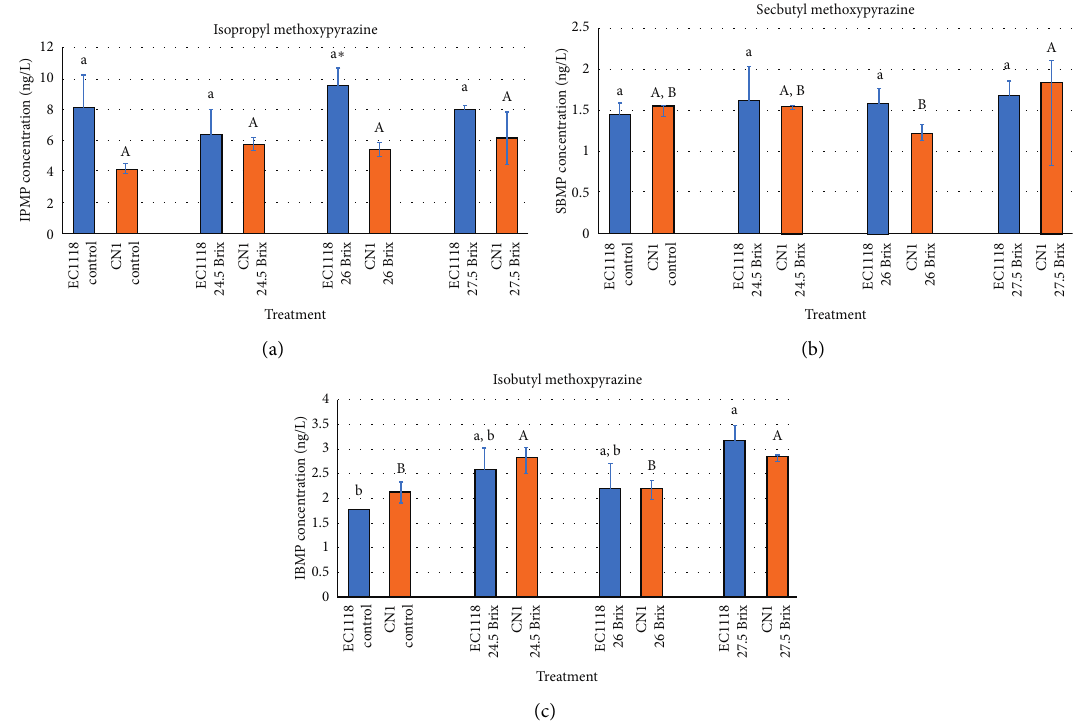
Figure 5: Concentrations of (a) IPMP, (b) SBMP, and (c) IBMP for control (no dehydration) and treatment wines made from partially dehydrated grapes fermented with S. cerevisiae EC1118 or S. uvarum CN1. Lowercase (EC1118) and uppercase (CN1) letters indicate statistical differences within the same yeast treatment determined by analysis of variance with mean separation by Fisher’s least significant difference ( p < 0 . 05). Asterisks ( ∗ p < 0 . 05, ∗∗ p < 0 . 01, and ∗∗∗ p < 0 . 001) indicate significant differences between yeast strains at the indicated dehydration target as determined by Student’s t